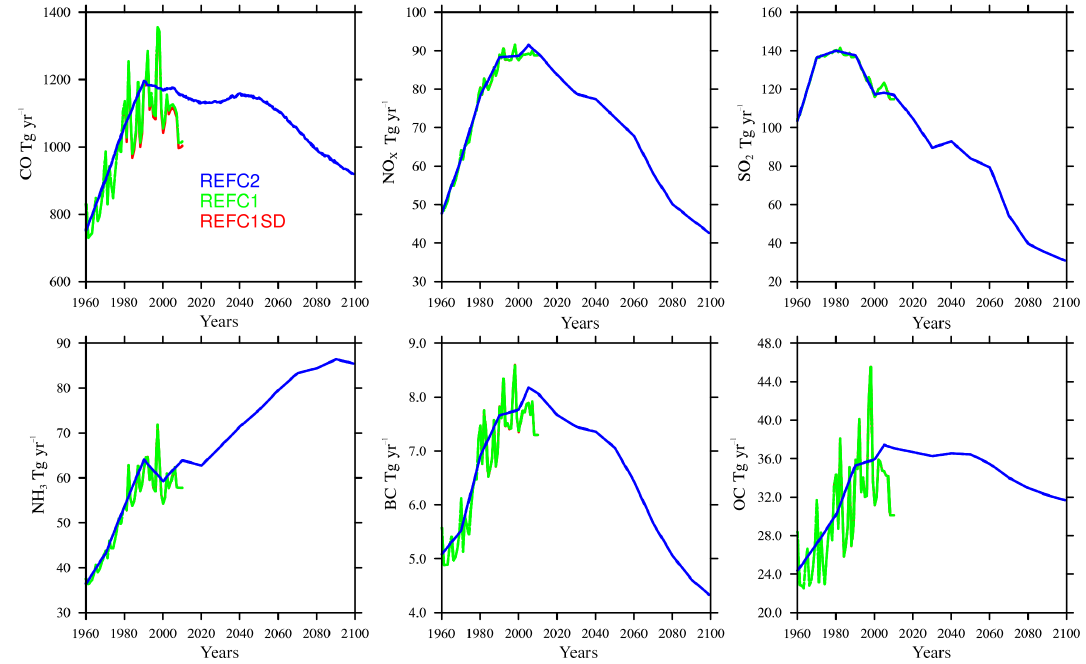
Figure A1. Selected surface emissions used for the different reference